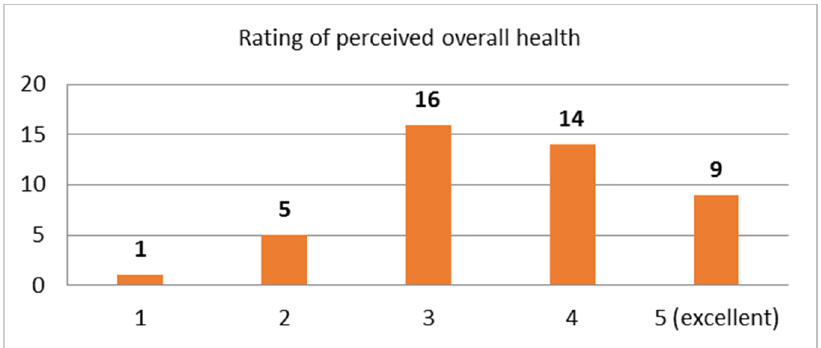
Figure 1. Distribution of rating scores for perceived overall health.